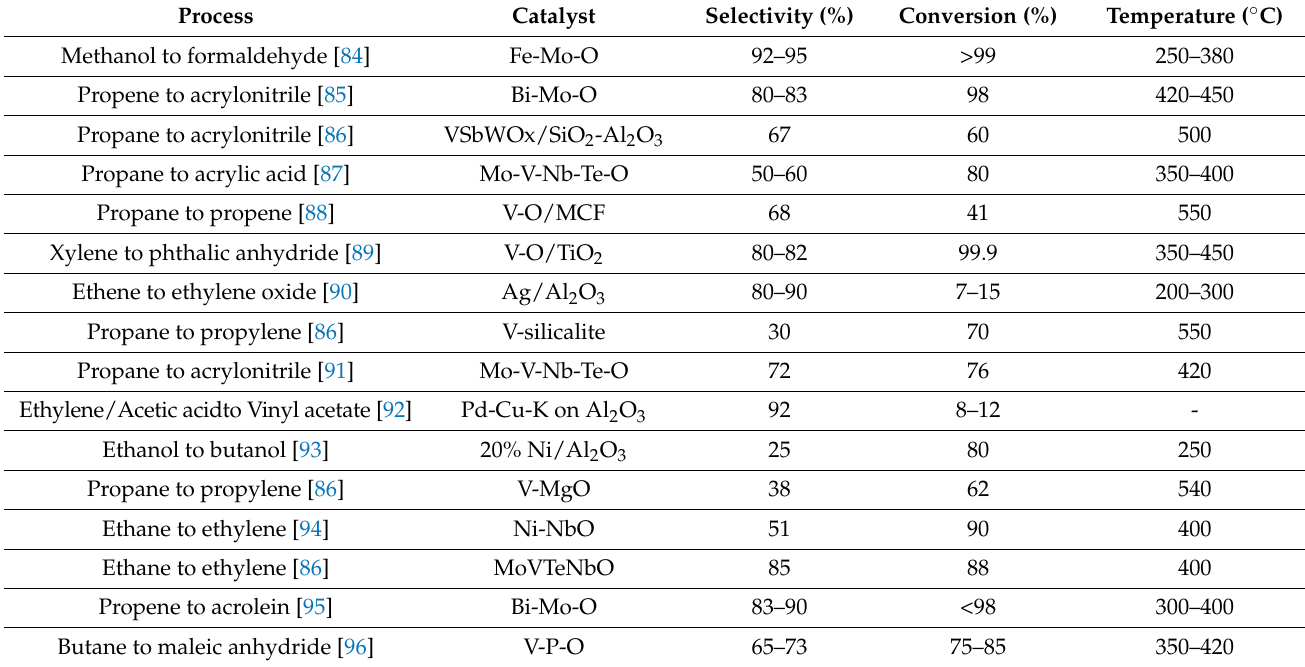
Table 2. Comparison of different oxide catalysts for selective hydrocarbon oxidation and oxidative dehydrogenation. Process